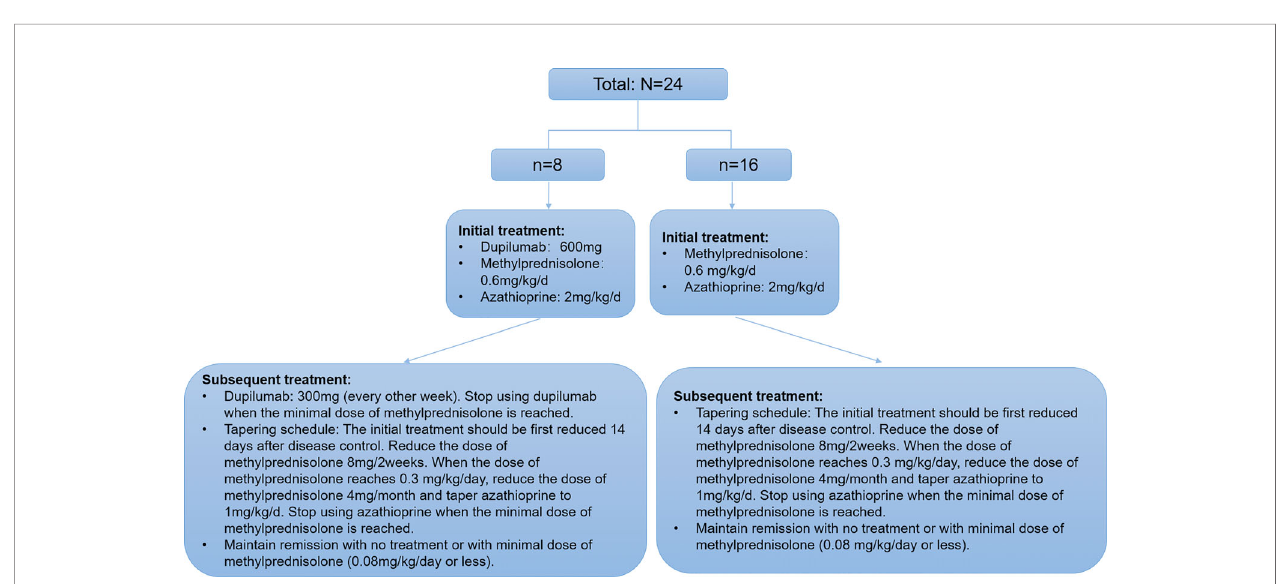
FIGURE 1 | Algorithm describing the distribution, the treatments, and taper schedule received by the patients with moderate-to-severe BP.